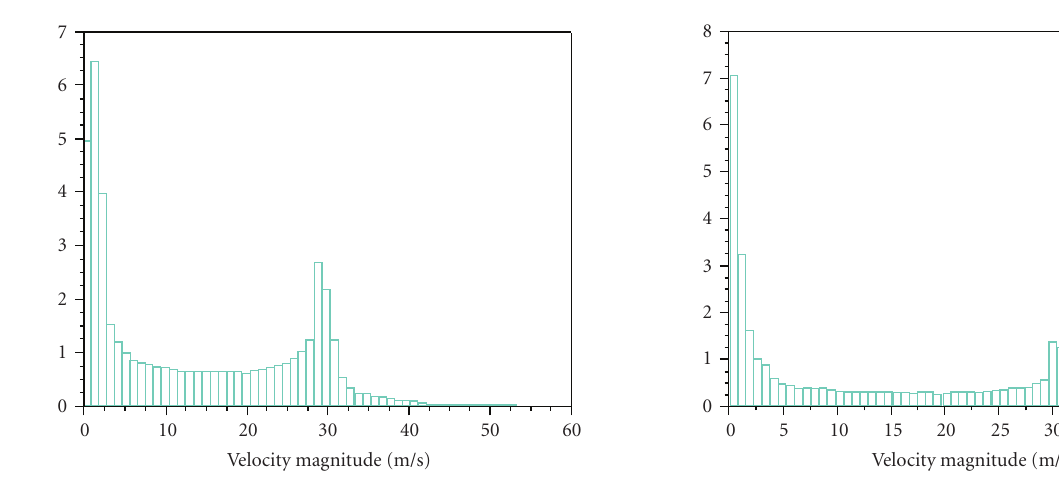
Figure 16: Bar chart showing (normalized) number of points versus velocity for SC cell “trs1” (LOFA—Average Channel).